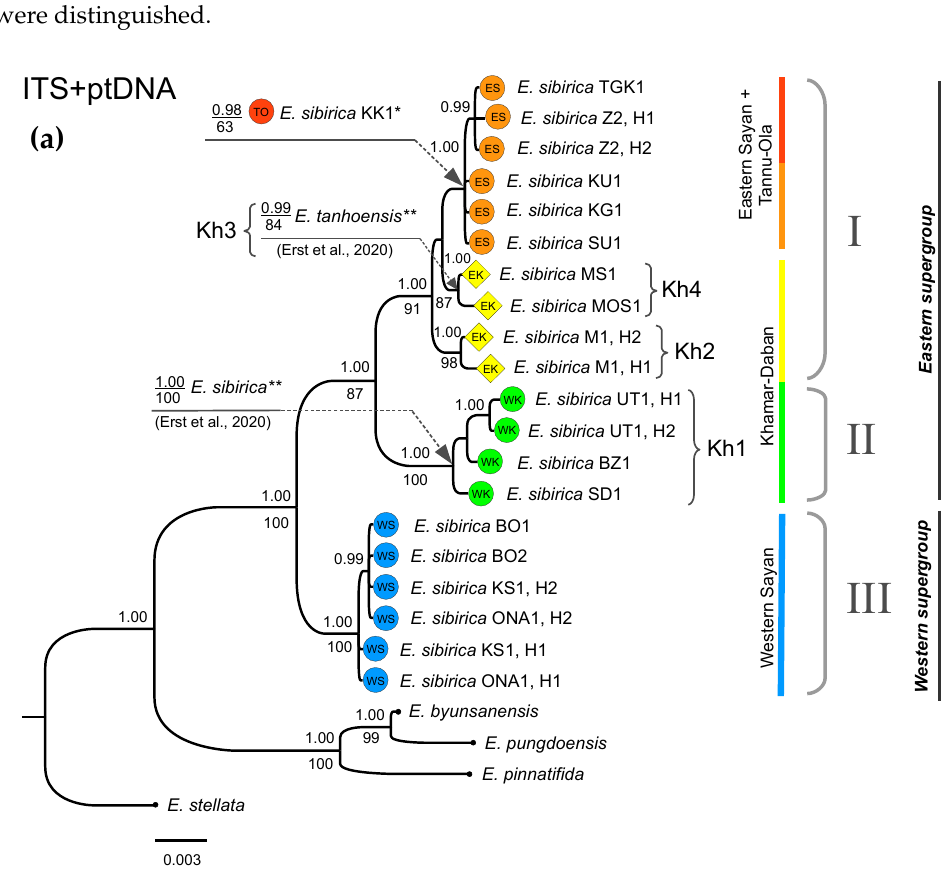
Figure 4. Phylogeny and phylogeographical patterns of Eranthis in South Siberia based on the com- bined ITS + ptDNA dataset. The color patterns and names correspond to those in Figure 1. Roman numerals indicate the main identified haplogroups/lineages. ( a ) BI phylogram. Posterior probabili- ties ≥ 0.95 are indicated above the branches, Bootstrap values for the corresponding clades on the ML tree (if relevant), below branches. The scale bar indicates the number of expected changes (sub- stitutions or/and indels and inversions) per site corresponding to a unit of branch length. *—branch position was inferred using the combined dataset of ITS and only trnL + trnL-trnF for ptDNA; **— branch positions were inferred from the independent analysis using ptDNA alignment with com- pletely deleted multiple indel regions and not including the binary matrix (see Section 2.4). Kh1– Kh4—the numbers of the Pleistocene microrefugia on the Khamar-Daban Ridge discussed in Section 4.1. ( b ) Geographical distribution of the haplogroups (lineage) identified in this study. Gray circles indicate the geographical patterns of E. sibirica distribution and the diamond symbol indicates the pattern of E. tanhoensis according to A.S. Erst and colleagues [5].